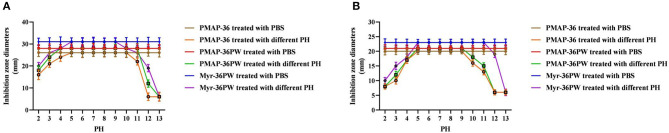
PH stability determination of Myr-36PW. PH stability test was performed using Myr-36PW and its analogs treated with different pH levels (2–13) through disk diffusion method. (A) (S. aureus ATCC 25923) and (B) (P. aeruginosa GIM 1.551) show the pH stability curve of PMAP-36, PMAP-36PW, and Myr-36PW. The diameter of the standard disk is 6 mm. Data represent the mean ± SD (n = 5).